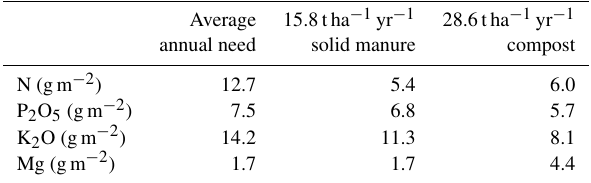
Table 3. Nutrient requirements and input: average annual need based on the fertilisation plan (Landwirtschaftliche Beratungszen- trale Lindau LBL, 2005), the input of the same nutrients with the annual application of 15.8tha − 1 yr − 1 of solid manure (based on the average concentrations of solid manure given in Table E1) and the annual application of 28.6tha − 1 yr − 1 of compost (based on concentrations from Landwirtschaftliche Beratungszentrale Lin- dau LBL, 2005), corresponding to an approximate C org input of 174gm − 2 yr − 1 . For N an efficiency of 60% was assumed for ma- nure and for compost as required by the regulations of PEP in the case of farmyard manure (Amaudruz et al.,